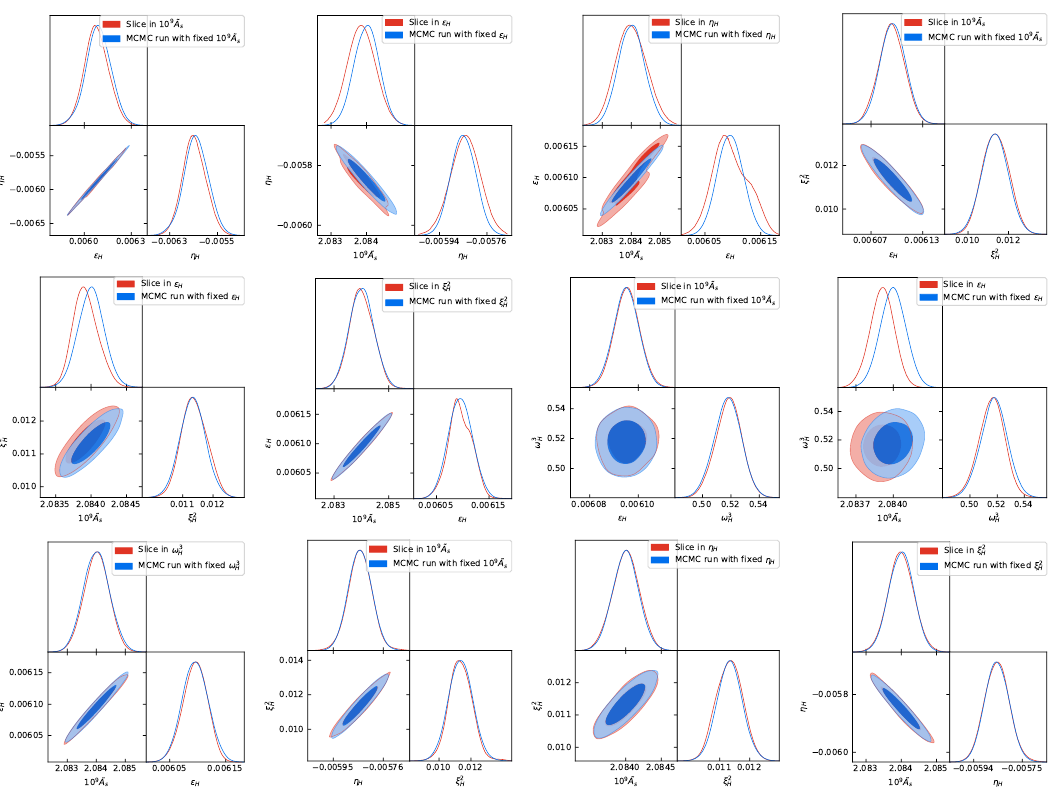
Figure 11: Comparison between slices and 2D contours using the SKA projections. Slices are taken from the 3D chains in Fig.